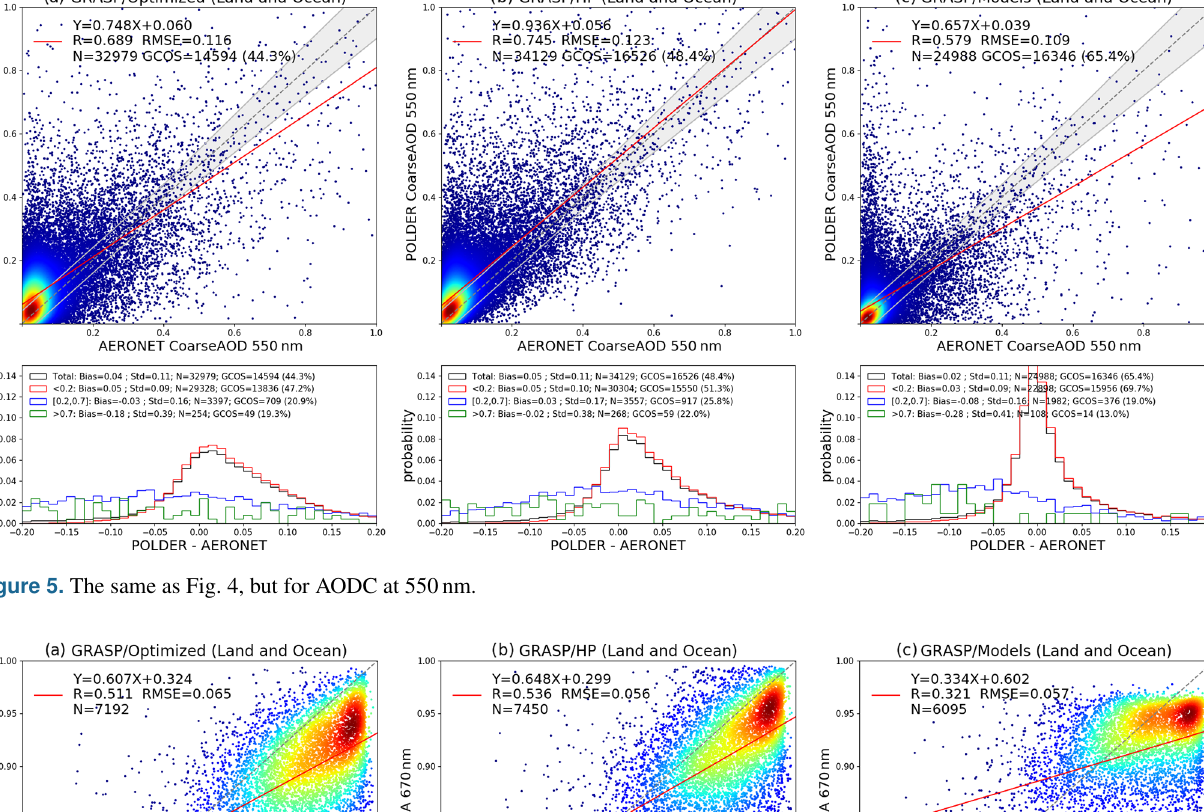
Figure 5. The same as Fig. 4, but for AODC at 550nm.